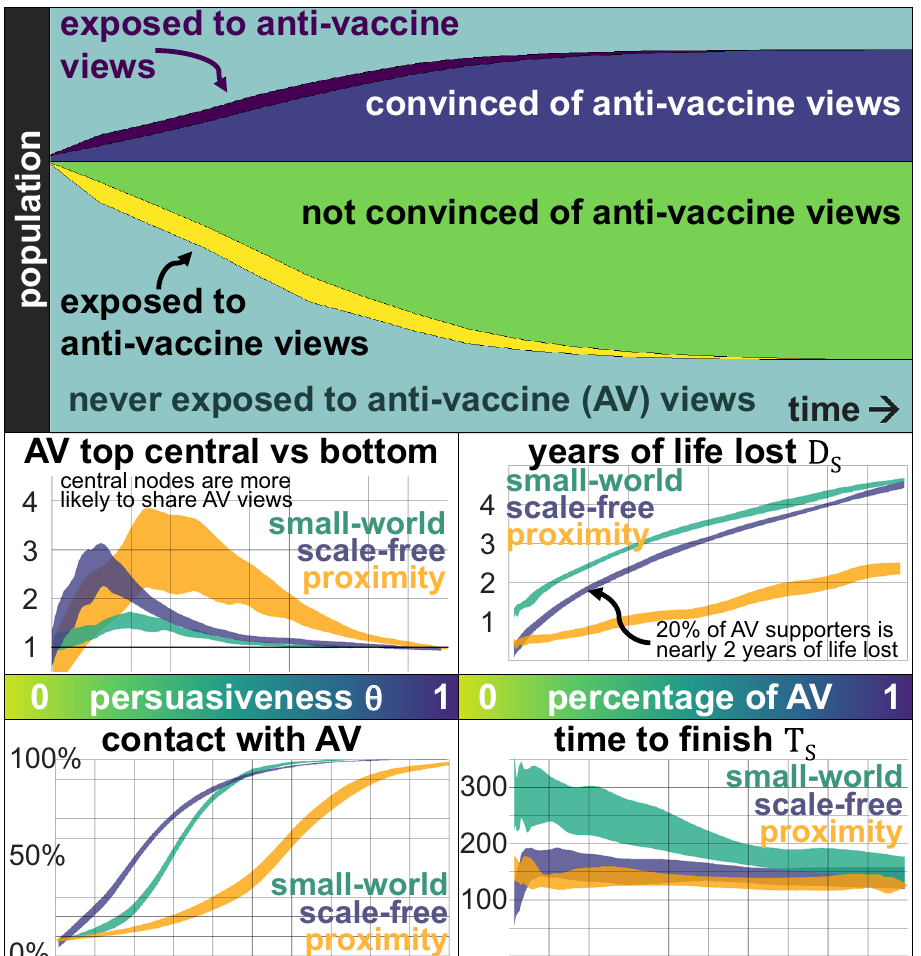
Figure 3. Anti-vaccine views are shared on a network of N = 5000 individuals, where some randomly-selected nodes initially share the views. The top panel shows the evolution of those who are exposed for the first time to anti-vaccine views (dark purple) and are convinced by them (dark blue), those who are exposed for the first time (yellow) but do not adopt them (green) and individuals who never have contact with them (light blue). The odds of a person sharing anti-vaccine views, comparing the top 10% most central nodes against the bottom 10% (central left panel) shows that for extreme values of θ , centrality does not have an impact (since all individuals share similar views), but for values in between, the most central nodes are two or more times more likely to share anti-vaccination views since they are more likely to be exposed. Since individuals are equally likely to adopt the views after their first exposure, more central individuals are more likely to adopt them. The impact is more pronounced on a proximity network (yellow) even when the network does not have nodes with a high degree, and a scale-free network (blue) than on a small-world network (green). By the end of the diffusion process of the anti-vaccination views (bottom left panel), even with a small persuasiveness θ , most individuals will have contact with those views. On a scale-free network, with persuasiveness of θ = 0.3 , around 70% of the population has contact with the views (even if most of them reject them and do not pass them onwards). The impact of the size of the anti-vaccine community (AV) is relevant in terms of the years of life lost D S (ν) (central right) and has some impact in terms of the time to finish T S (ν) , considering a vaccination rate of 30%. Assuming a Degree vaccination strategy, we see that if 20% of the people support anti-vaccination views, nearly two years of life are lost (so that D S ( 0.3 ) ≈ 2 years). However, with a vaccination rate of 0.3 and the Degree vaccination strategy, only 0.3 years of life are